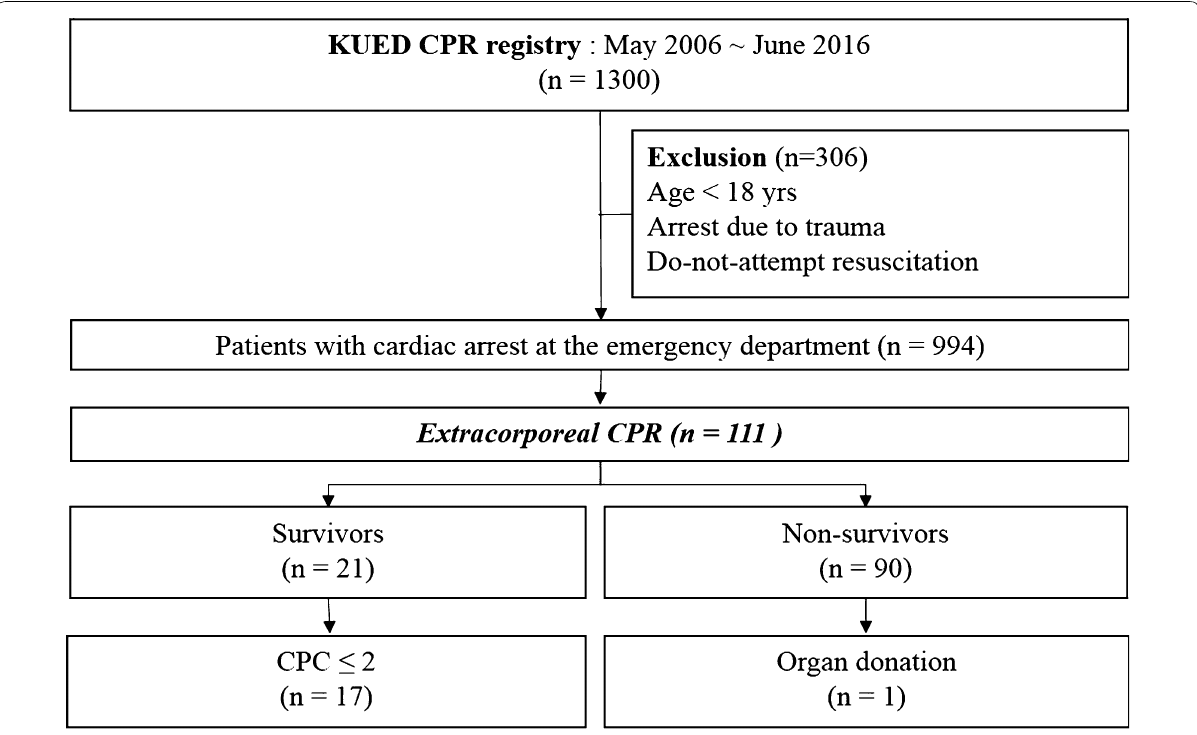
Fig. 1 Flowchart of selection of study patients and